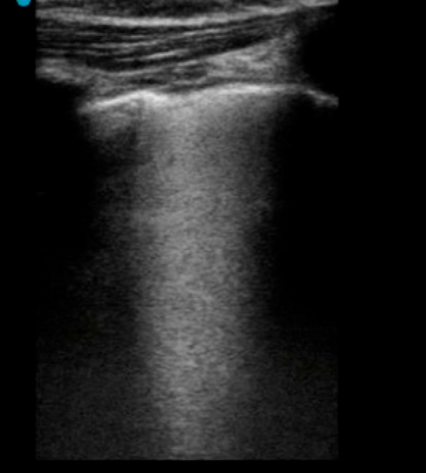
Figure 3. The presence of coalescent B-lines (white lung) in the pulmonary parenchyma of a child with COVID-19 infection.